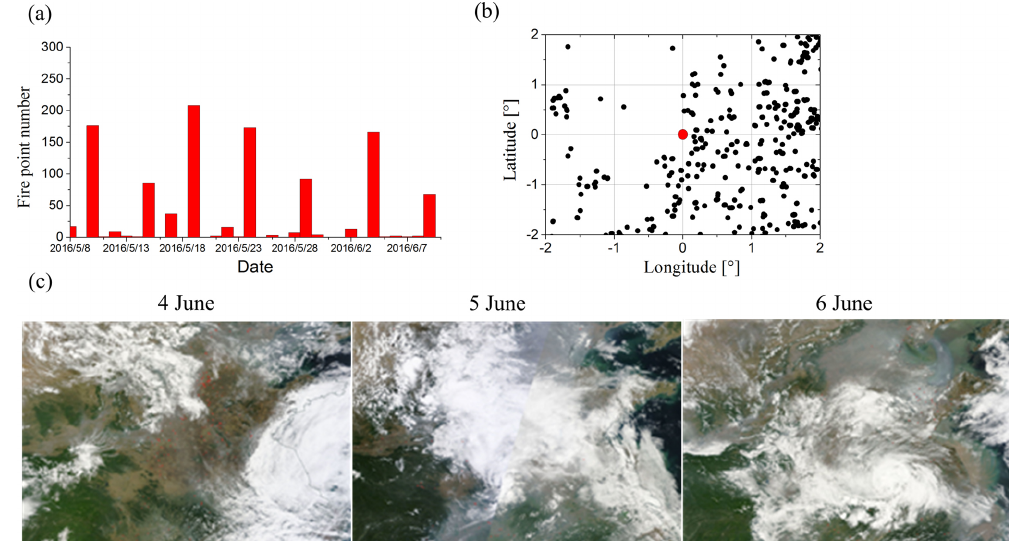
Figure 14. (a) Daily total numbers of fire counts in the NCP region. (b) Distributions of fire points in the 2 ◦ × 2 ◦ (180km 2 ) area around the measurement site. (c) Images of the NCP region derived from MODIS observations; blue circles and red dots represent the measurement station and fire points,